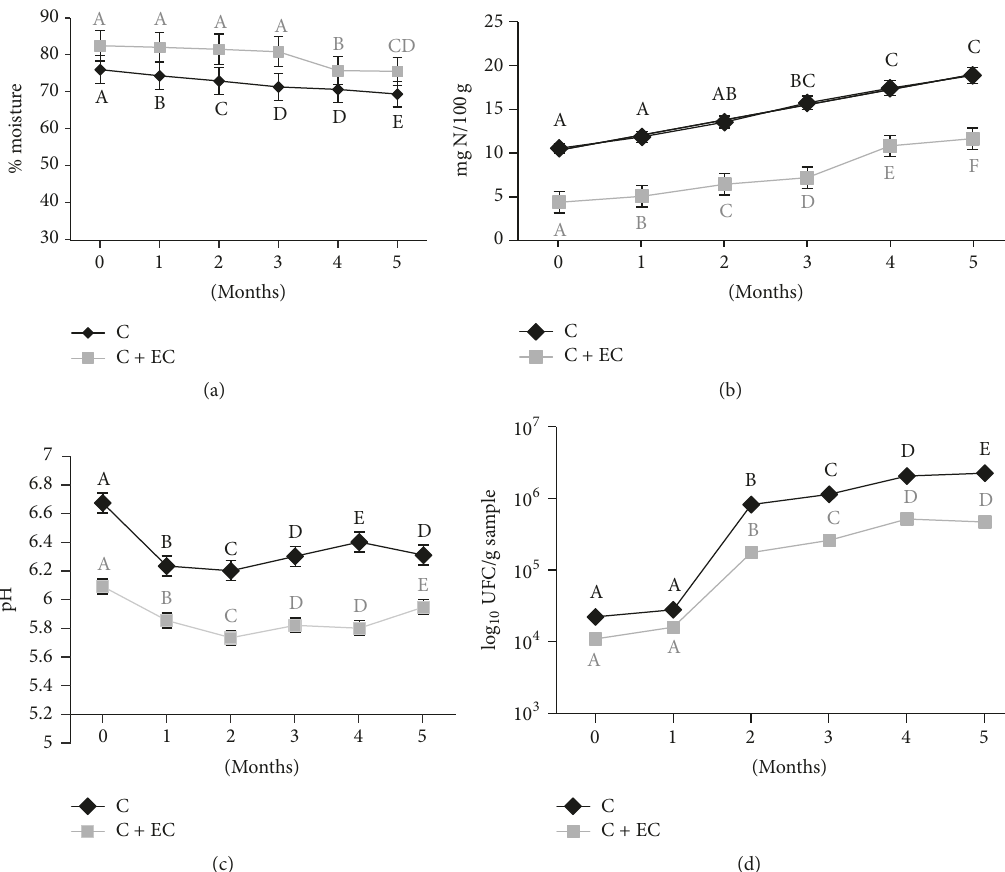
Figure 1: Changes in moisture (a), total volatile basic nitrogen TVB-N (b), pH (c), and total viable count (TVC) (d) values of common carp fillets stored at − 18 ∘ C for 5 months. The results are the mean of three replications. C: fillet carp without coating; C + EC: fillet carp with edible coating. The different letters indicate significant differences between treatment times for the same treatment ( 𝑝 < 0.05